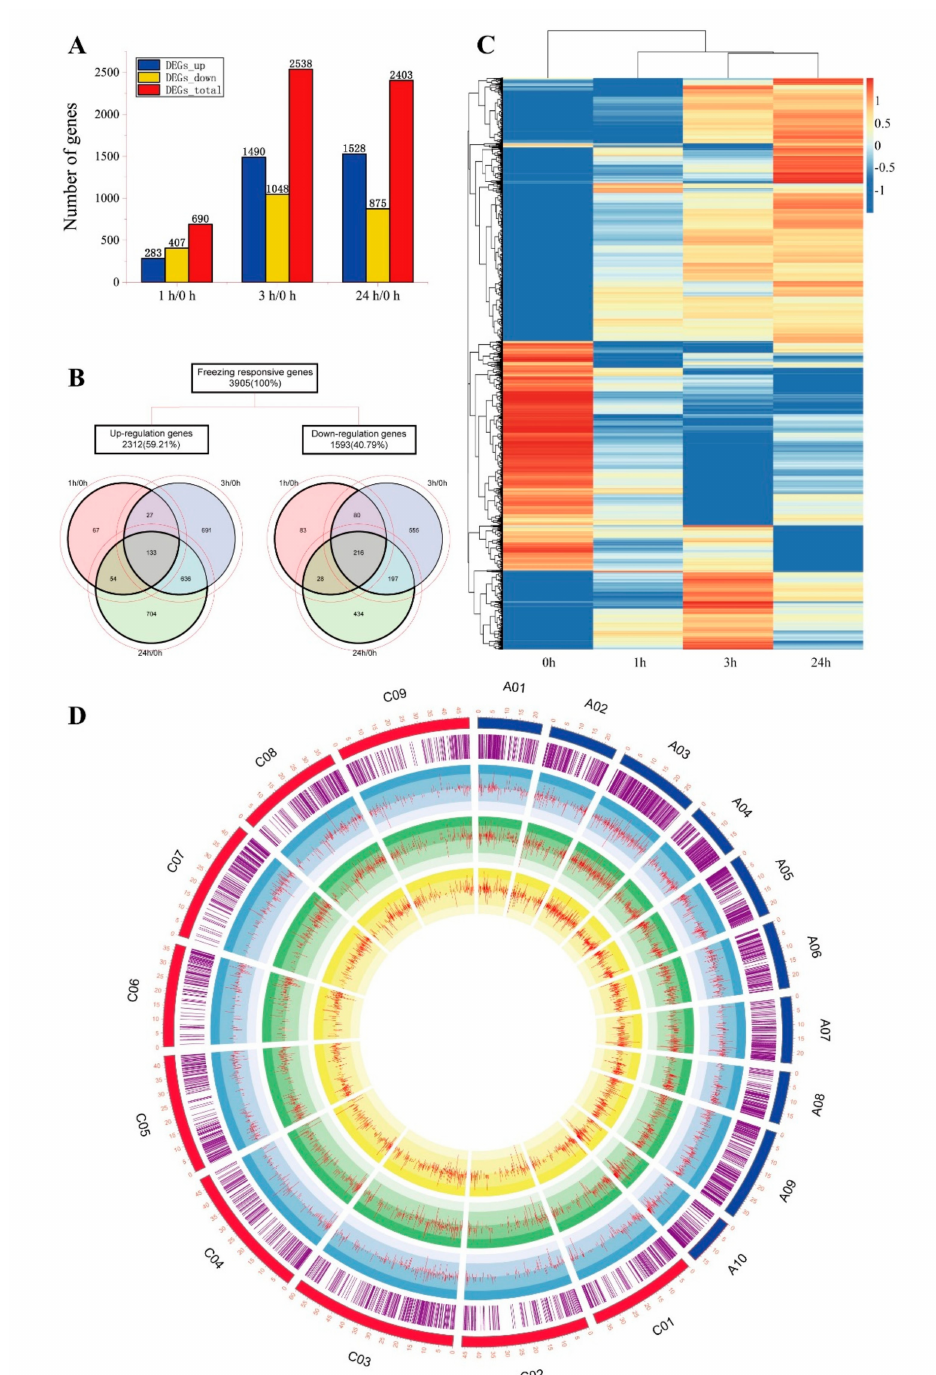
Figure 3. The expression profile of chilling regulated di ff erentially expressed genes (DEGs) in Brassica napus leaves. ( A ) Column diagram representing the numbers of DEGs in three groups. ( B ) Venn diagrams representing the numbers of DEGs and the overlaps of sets obtained across three comparisons. ( C ) The heat maps representing 3905 DEGs expression profiles after freezing treatment. ( D ) the Circos Plot shows that the distribution of DEGs on 19 chromosomes and expression of DEGs in di ff erent time points. Red and blue showed the sizes of the 19 chromosomes of B. napus . The purple circle represents the distribution of DEGs on each chromosome. Light blue represents expression (log2 FC) of DEGs at 1 h vs 0 h, light green represents expression (log2 FC) of DEGs at 3 h vs 0 h and yellow represents expression (log2 FC) of DEGs at 24 h vs. 0